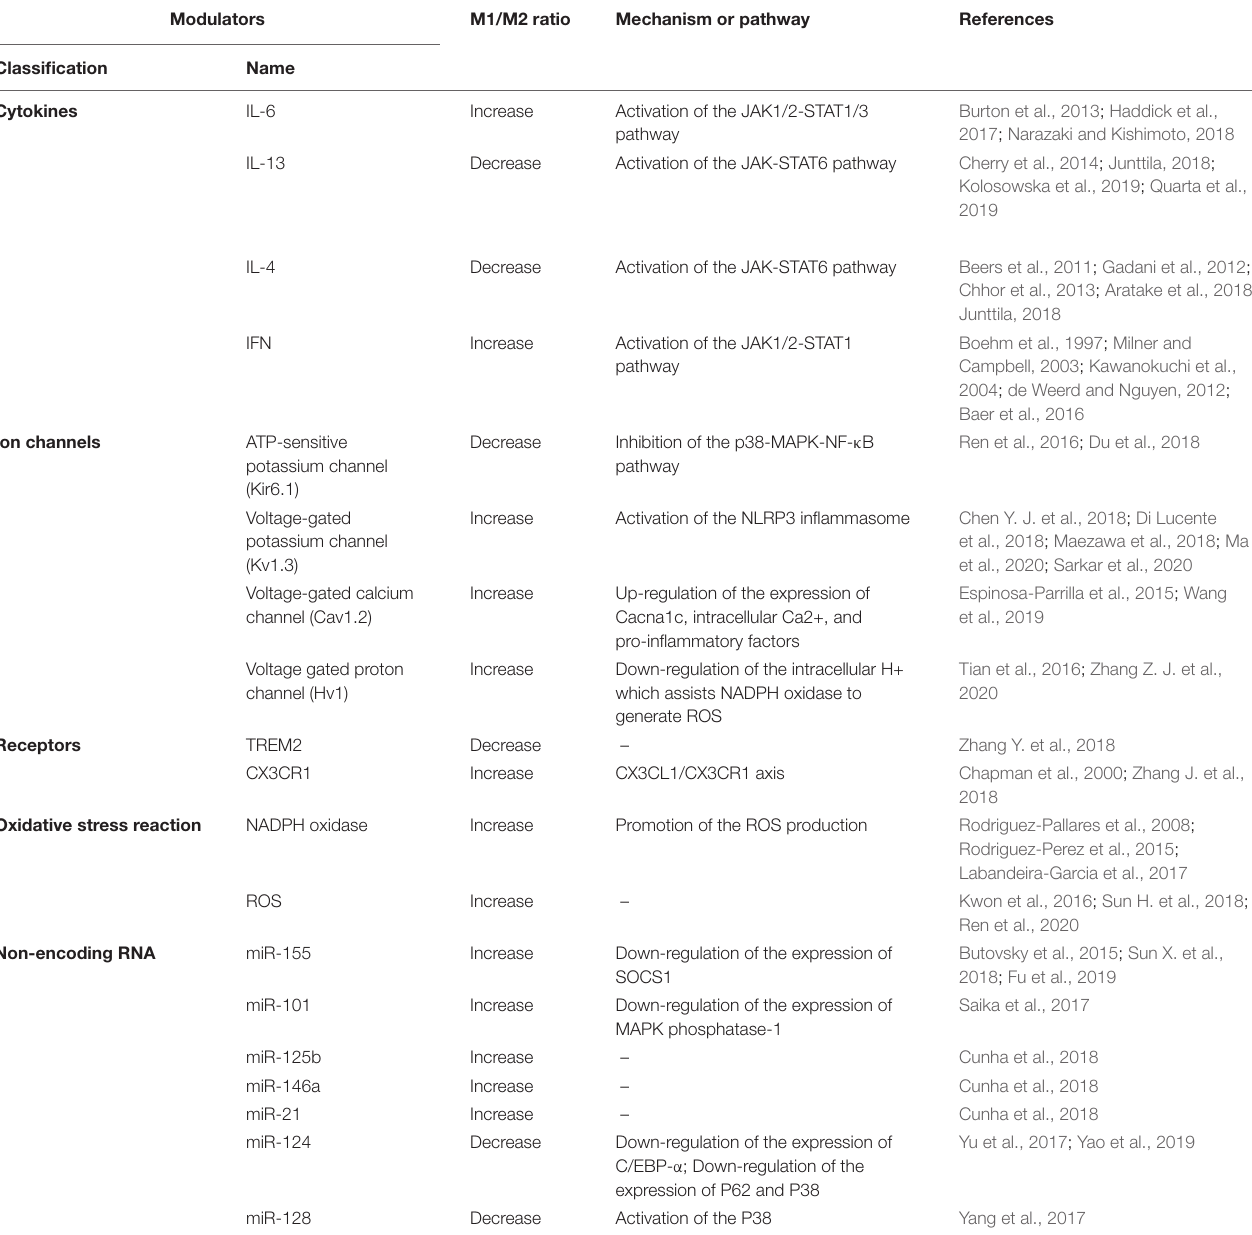
TABLE 2 | Modulators of microglia phenotypic